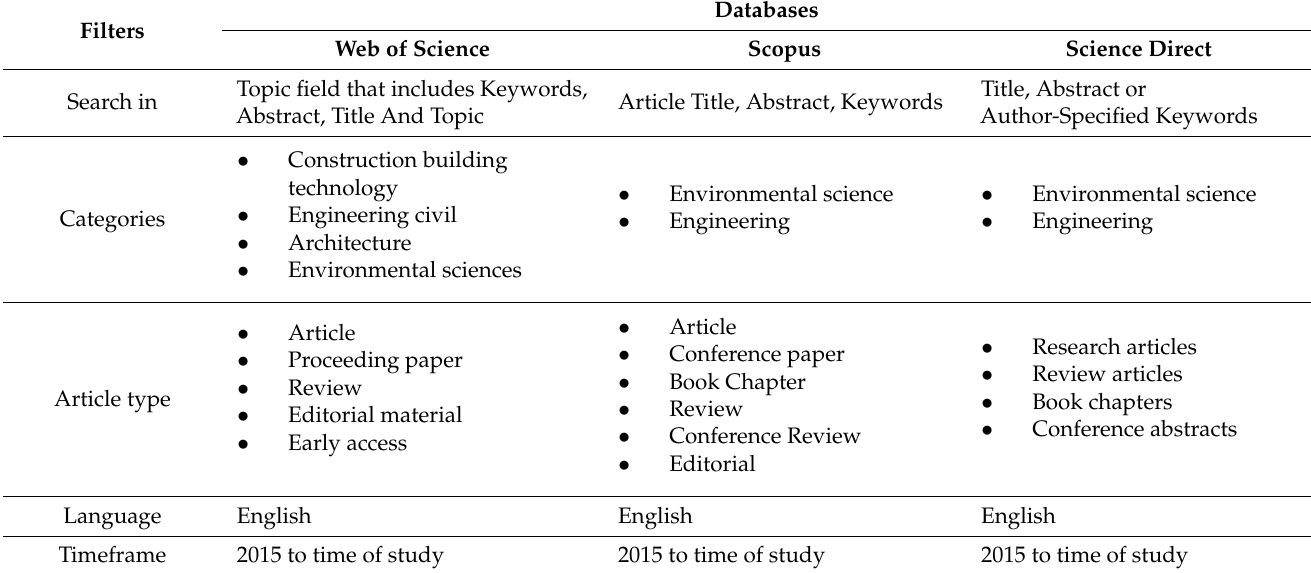
Table 2. Filters applied to database search.